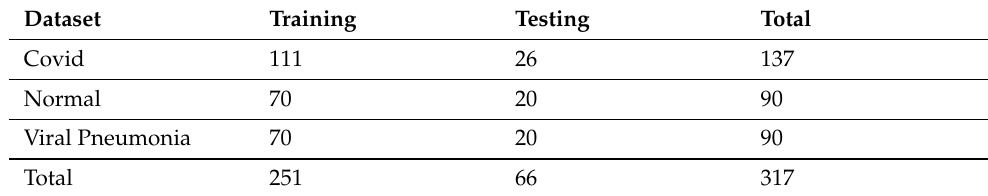
Table 3. Dataset Division.